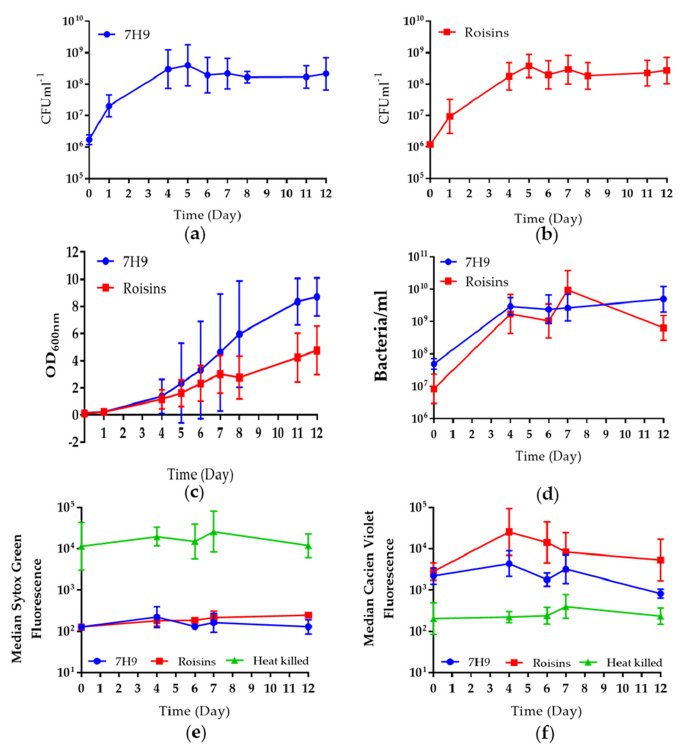
Figure 2. The total viable counts of fermenter-grown M. bovis BCG in 800 mL of either Middlebrook 7H9 ( a ) or Roisin’s minimal medium ( b ) over 12 days of culture in batch fermenters. The cultures were sampled daily for total viable counts (CFU mL − 1 ) ( a , b ) and turbidity ( c ). Samples were taken on days 0, 4, 6, 7 & 12 for total bacterial counts (Bacteria / mL) determined using fluorogenic beads and flow cytometry ( d ). Samples were taken on the same days for analyses of cell death and metabolic state using flow cytometry and fluorescent dyes, sytox green ( e ) and calcein violet ( f ), respectively. A heat-killed M. bovis BCG control was included. Data represent the mean average of three independent culture repeats ± standard